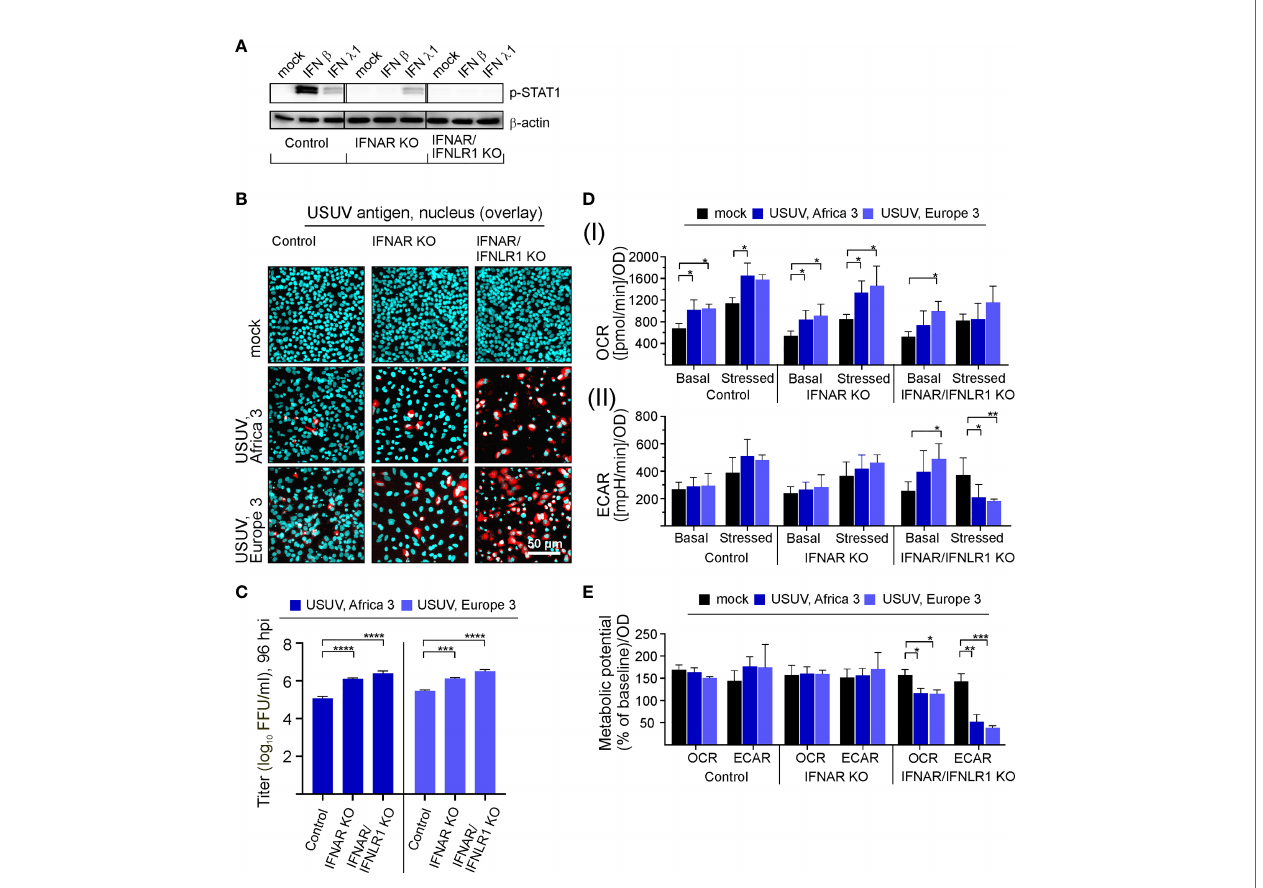
FIGURE 4 | Type I and III IFN signaling in fl uences permissiveness of A549 cells to USUV infection-associated metabolic alterations. (A) Western blot analysis of A549 cells with KO of the type I IFN receptor IFNAR either solely or together with the type III IFN receptor (IFNLR1) and A549 control cells. Antibodies against phosphorylated STAT1 were used for analysis of samples with exogenous IFN b (10 ng/ml) or IFN l 1 (100 ng/ml) after an incubation for 24 h. (B – E) Infection with USUV strain Africa 3 and Europe 3 at MOI 0.1 was analyzed at 96 hpi. (B) Immuno fl uorescence analysis with pan- fl avivirus antibodies (representatively shown in red for n = 3 with nuclear counterstain in blue). (C) Virus yield was determined by focus-forming assay. (D) Extracellular fl ux measurement with the cell energy phenotype test kit to determine (I) OCR and (II) ECAR values at basal and stressed (after co-application of 0.8 µM FCCP and 1 µM oligomycin) conditions. (E) The metabolic potential was determined through the percent increase in stressed OCR and ECAR over basal OCR and ECAR. (C – E) Data (n = 3) are shown as mean ± SD involving statistical analysis in comparison to the control performed by ANOVA and Dunnett ’ s post-hoc multiple comparisons test. Statistical signi fi cance is shown as *p < 0.05, **p < 0.01, ***p < 0.001) and ****p <